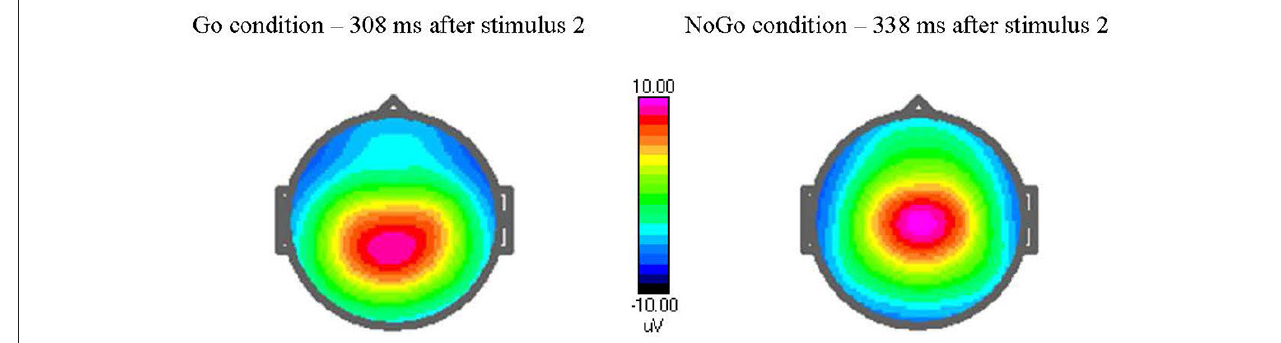
FIGURE 1 | Amplitude voltage map [in µ volts ( µ V)] at peak latency in Go and NoGo trials. The cued Go NoGo task elicits a maximum Go P3-component after 308 ms when stimulus 2 is target (Go condition) and a NoGo P3-component after 338 ms when stimulus 2 is non-target. Observe the topography of the P3, with a maximum at more parietal site in Go condition and centrally in NoGo